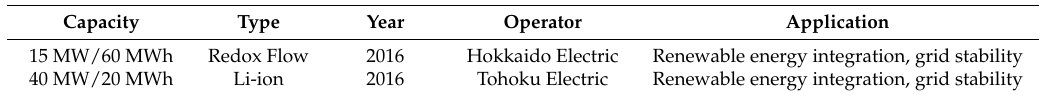
Table 4. Ministry of Economy, Trade and Industry (METI) battery storage demonstration projects